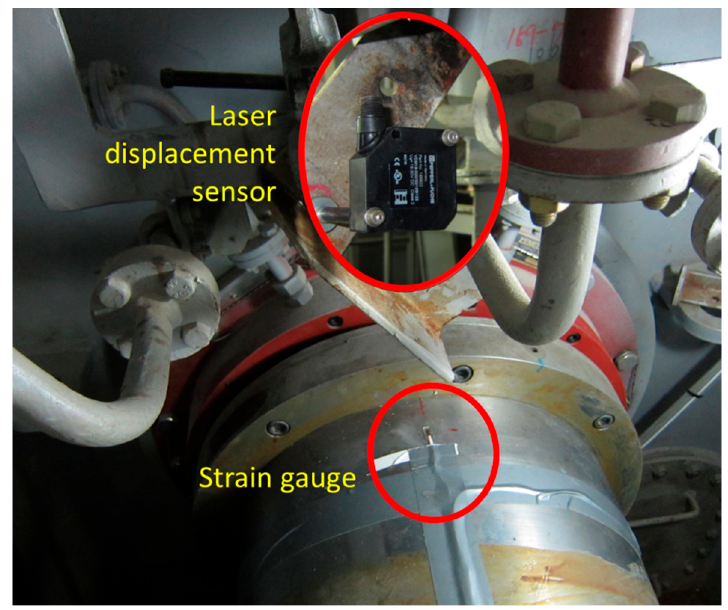
Figure 5. Equipment installation in engine room.